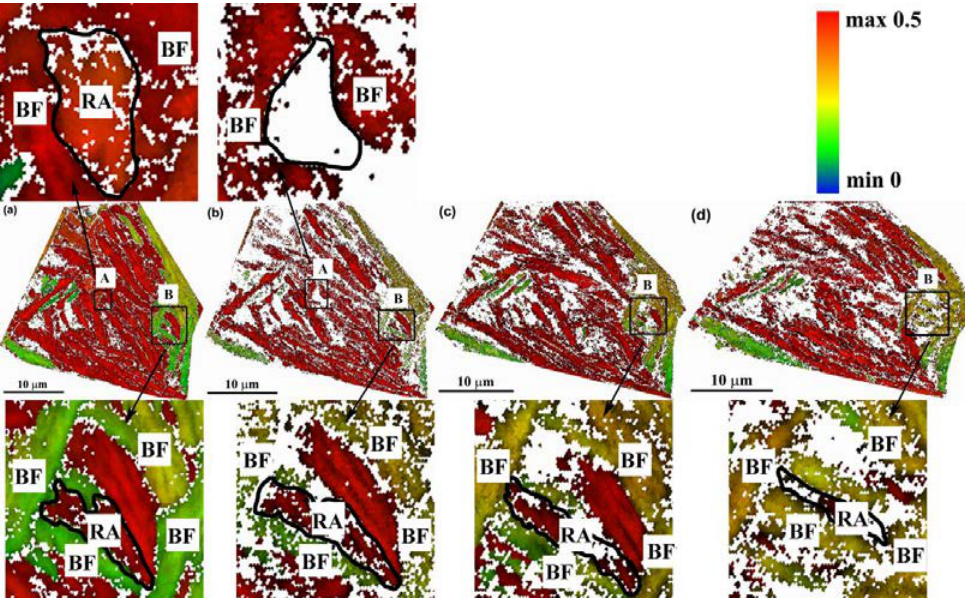
Figure 6. Schmid factor maps in the studied region at different strains: ( a ) 0, ( b ) 0.025, ( c ) 0.054, and ( d ) 0.104.